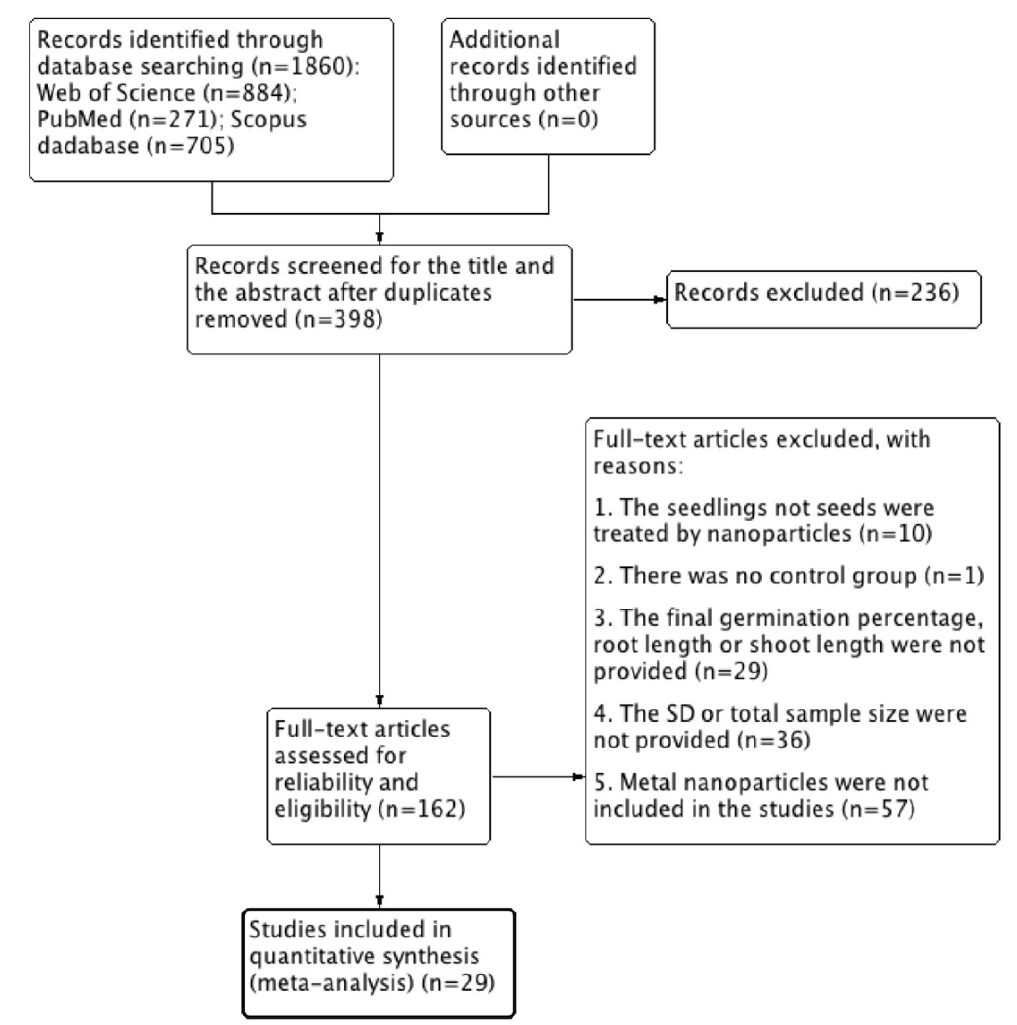
Figure 2. Flow chart of the study selection in the meta ‐ analysis.